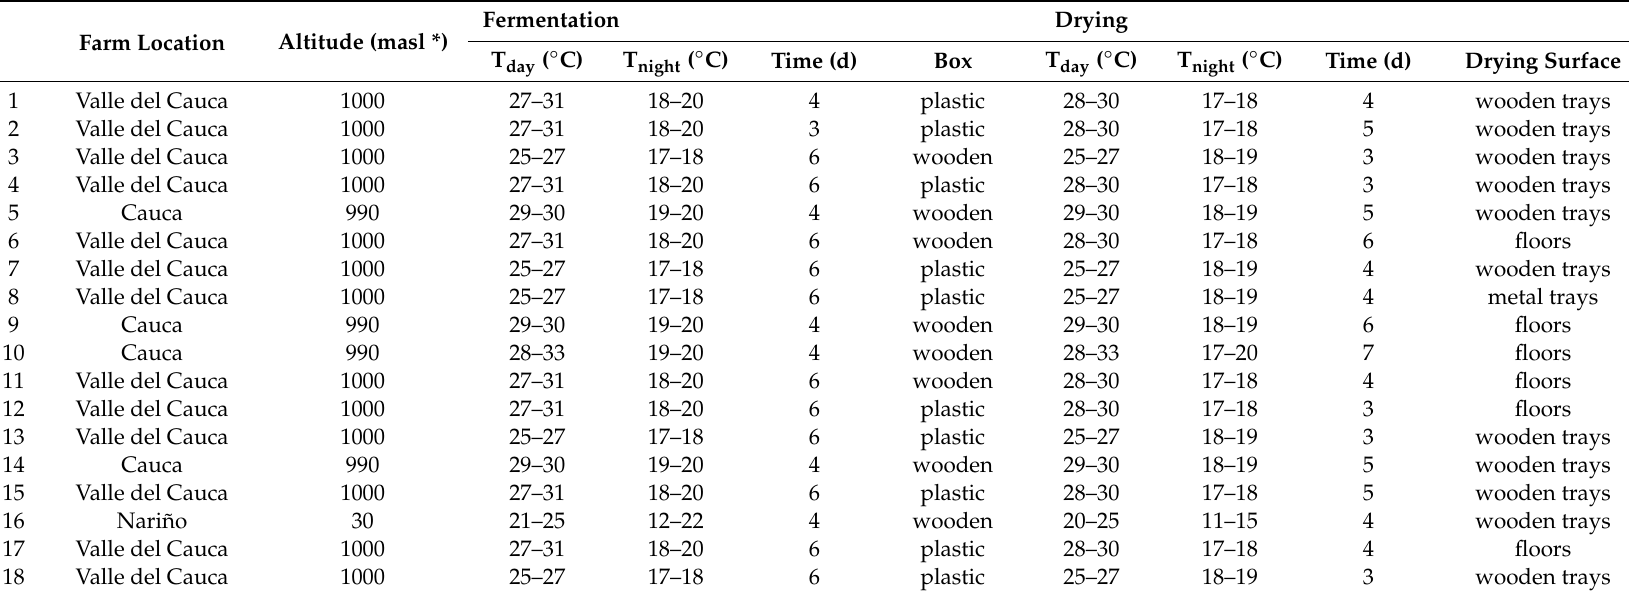
Table 1. Geographical characteristics of the area of origin and fermentation and drying condition of the cocoa